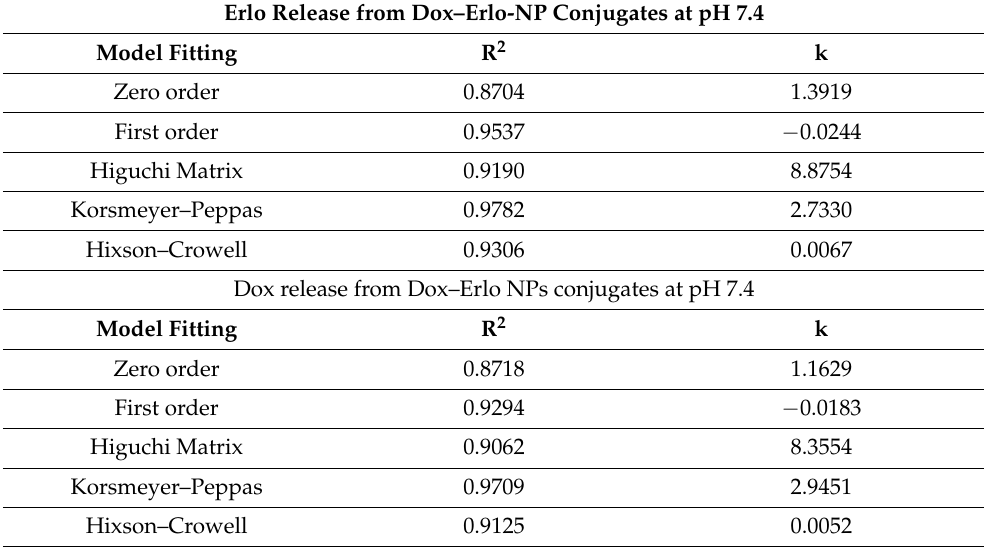
Table 7. Kinetic drug release of Erlo and Dox release from Dox–Erlo-NP conjugates at pH 7.4. Erlo Release from Dox–Erlo-NP Conjugates at pH